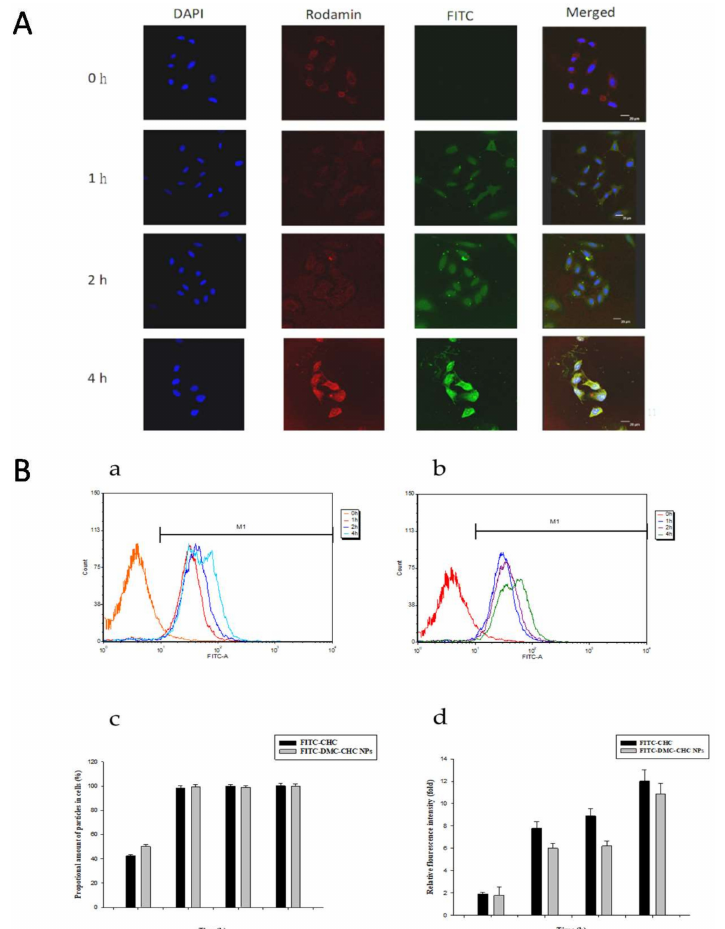
Figure 2. ( A ) Fluorescence images of A549 incubated with the DMC-CHC nanoparticles (5 µ g/mL) for 0–4 h. The merged image was the overlapping image obtained using the DAPI channel (blue, nuclei), rhodamine channel (red, F-actin), and FITC channel (green, nanoparticles). (B) Nanoparticles uptake efficiency measured by flow cytometer ( a ) 20 µ g/mL FITC-CHC and ( b ) 5 µ g/mL FITC-DMC-CHC NPs in A549. A549 were administered with or without FITC-DMC-CHC NPs for various time intervals (0–4 h). ( c ) To compare the proportional amount of nanoparticles, and ( d ) relative fluorescence intensity between FITC-CHC and FITC-DMC-CHC NPs in A549 cancer cells (M1). 10,000 cells were randomly chosen for imaging analysis with flow cytometer. Each data point is represented as the mean ± SD ( n = 3). Error bars represent the standard